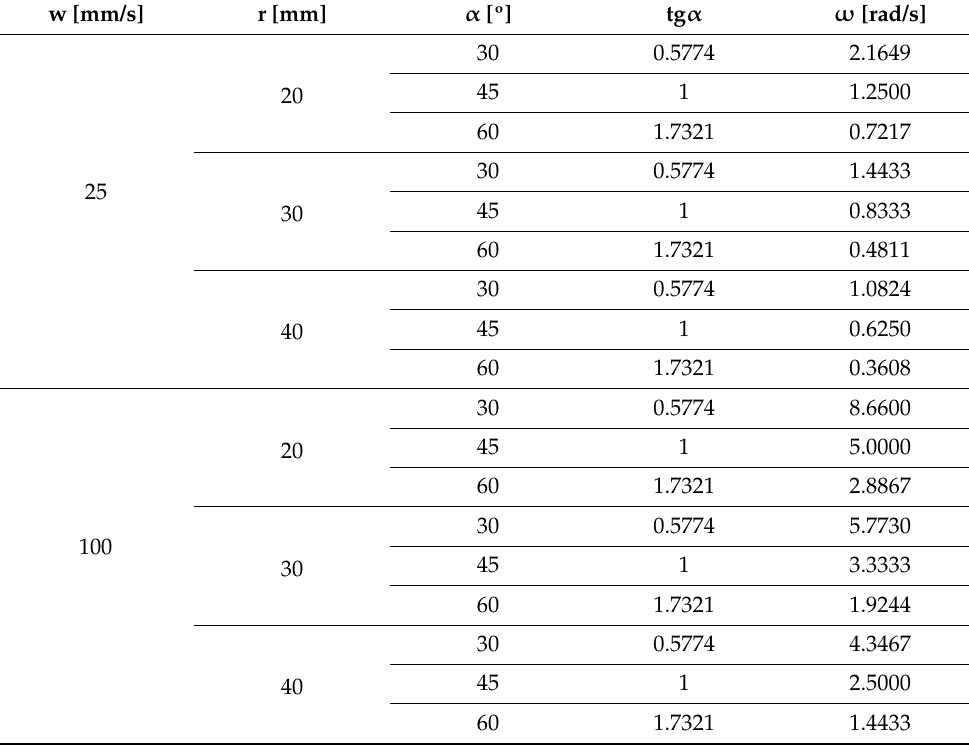
Table 2. Calculation of guide-line angular speed ω of depending on parameters in relation